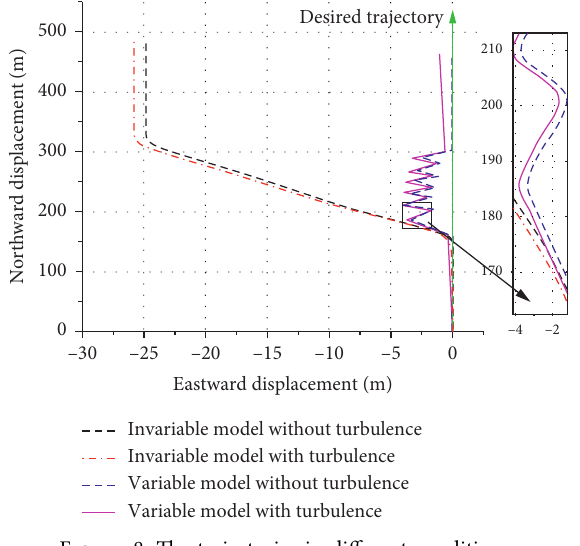
Figure 8: The trajectories in different conditions.